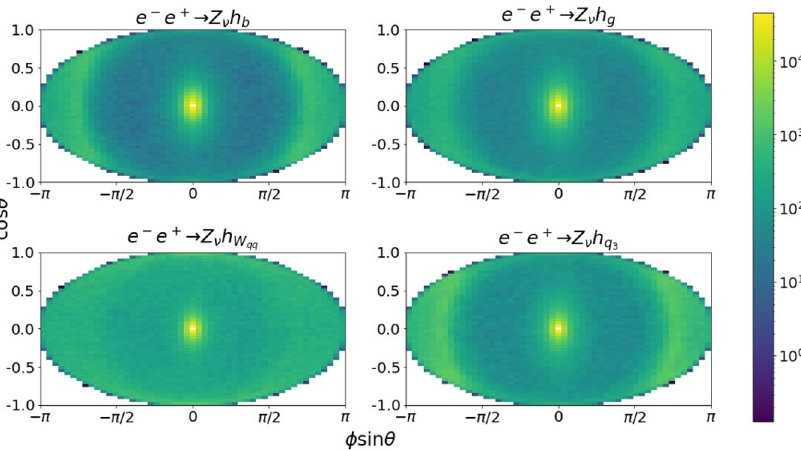
Figure 3 . Cumulative Mollweide projections of 10000 events: Z (cid:23) h b (upper-left), Z (cid:23) h g (upper- right), Z (cid:23) h W (bottom-left) and Z (cid:23) h q (bottom-right), with the brightness of each cell scaling qq 3 with the total energy (GeV) of the particle hits